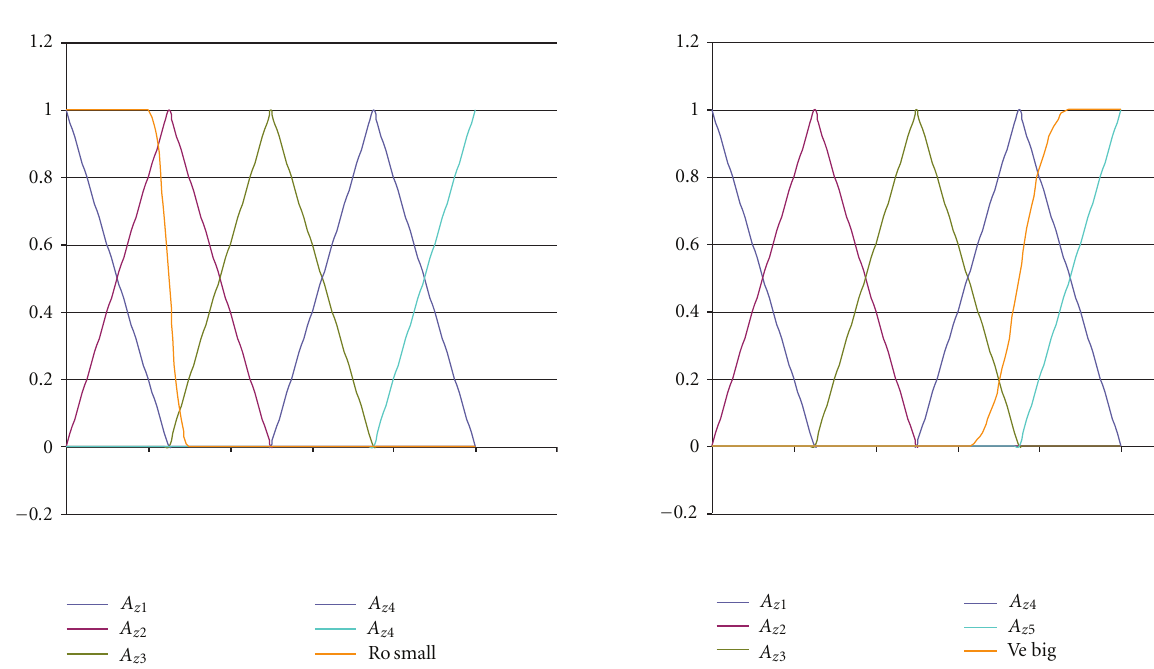
sets “ (cid:9) hedge (cid:10) big” (like “Ex big” and “Ro big”) assuming the value 1. In order to use the formulae (18), the dataset has to be su ffi ciently dense with respect to the chosen fuzzy partitions of basic